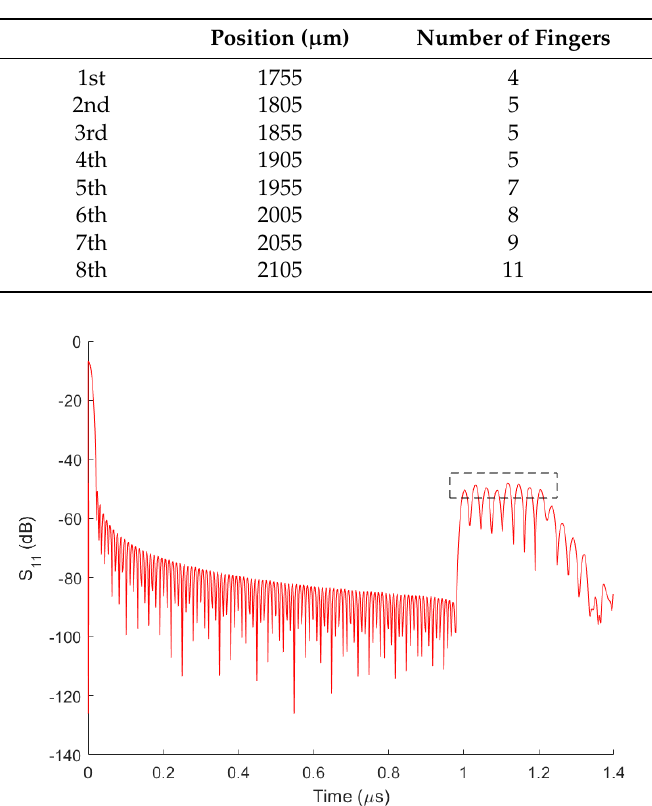
Table 1. Reflector design parameters of the reflective delay line sensor.